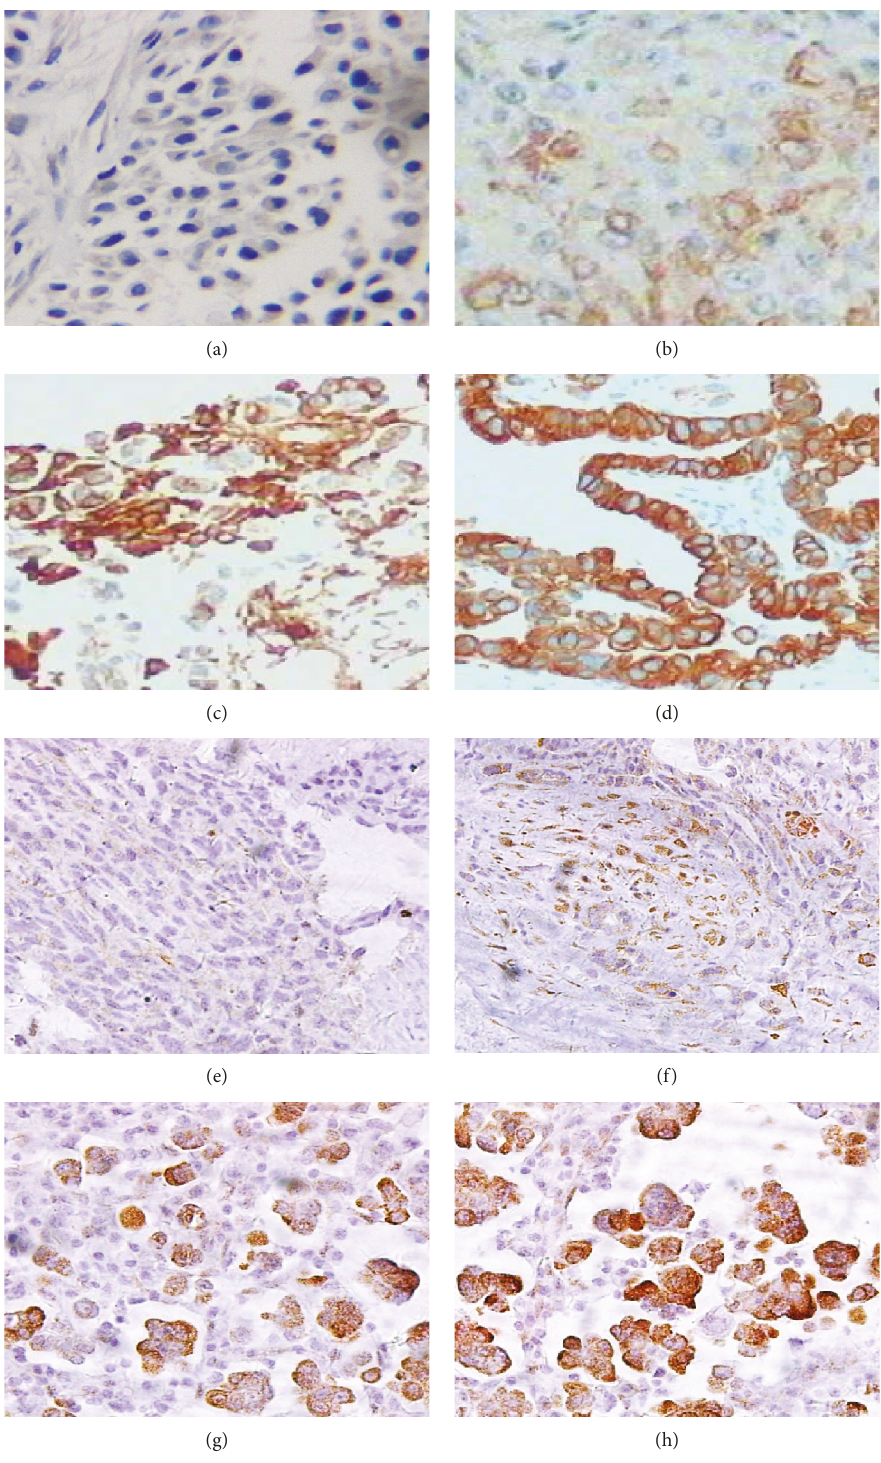
Figure 1: Expression of EGFR and PTEN in epithelioid MPeM tissue. EGFR was based on a membranous staining pattern, and PTEN was detected in the cytoplasm (a and e). Negative for EGFR and PTEN expression. (b and f) Weak expression of EGFR and PTEN in epithelioid MPeM tissue; minority of peritoneal cells are stained yellow. (c and g) Moderate expression of EGFR and PTEN in epithelioid MPeM tissue; a medium quantity of peritoneal cells are stained yellow or brown. (d and h) Strong expression of EGFR and PTEN in epithelioid MPeM tissue; majority of peritoneal cells are stained yellow or brown ( ×